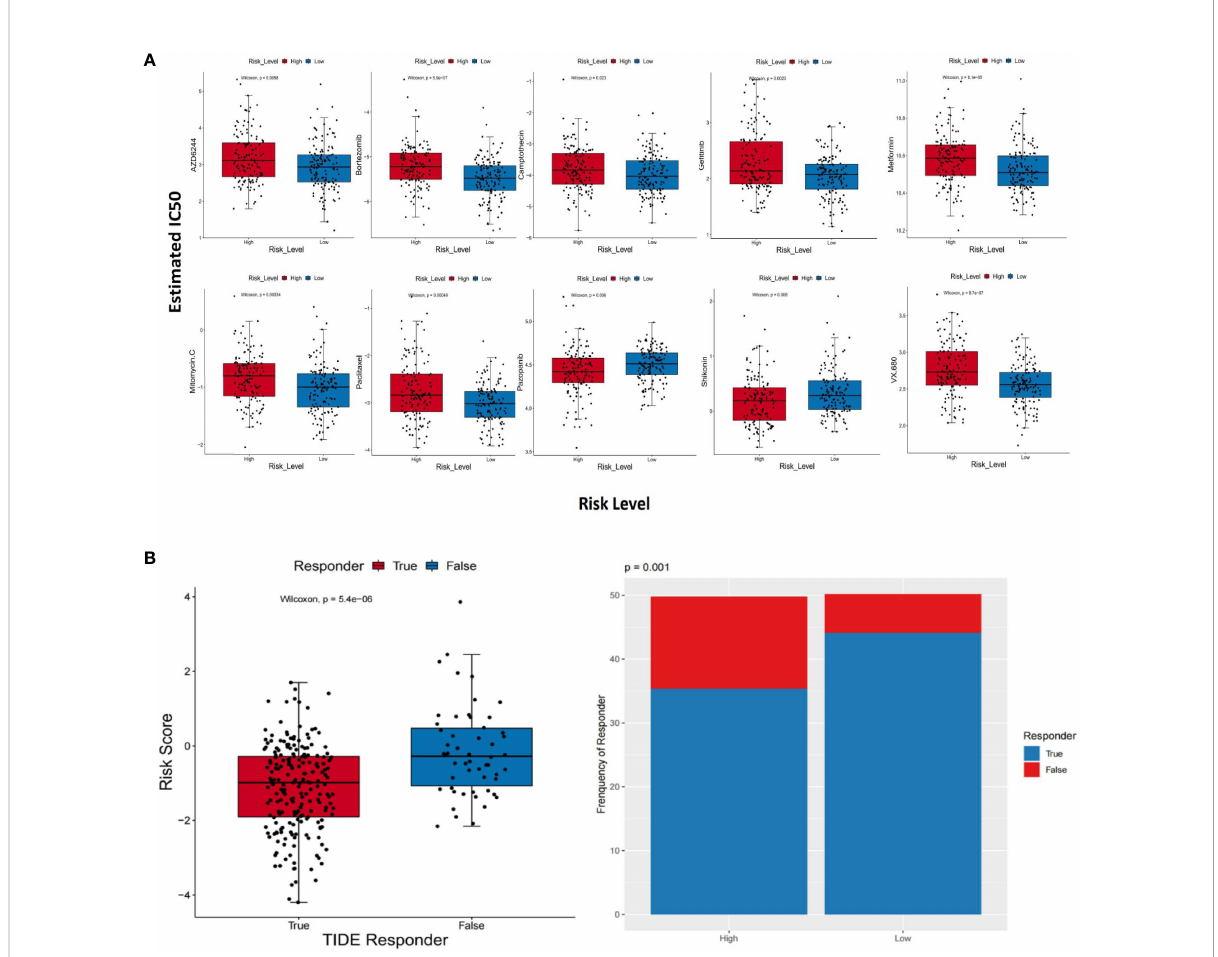
FIGURE 9 Different response sensitivities of therapeutic agents and immunotherapy. (A) Box plots which revealed the IC 50 values of 10 therapeutic agents between the two groups. (B) The results based on the TIDE method. The risk scores between the TIDE responders and non-responders (Wilcoxon test, p = 5.4e − 06) and distributions of responders and non-responders between the two groups (chi-square test, p =